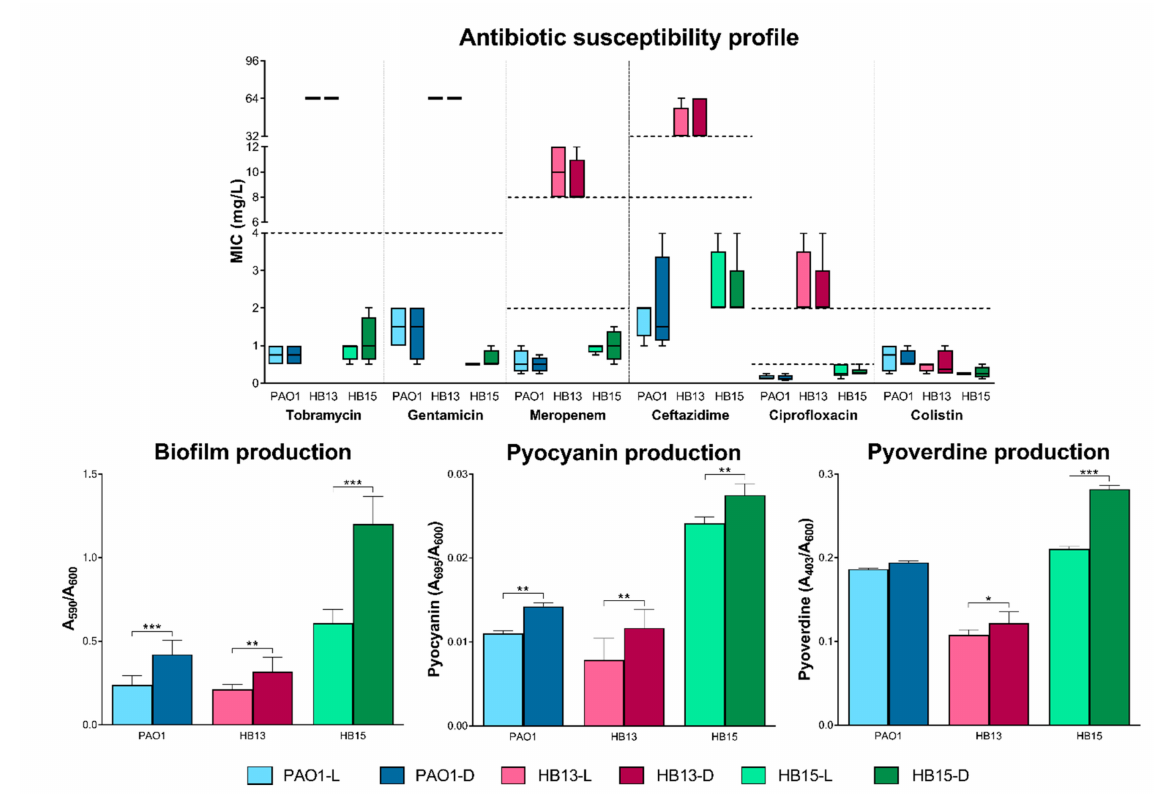
Figure 1. Phenotypic characterization of Pseudomonas aeruginosa grown in constant exposure to full-spectrum light (L) and total absence of light (D). Box and whiskers plots of the MICs of the six antibiotics screened, determined by broth microdi- lution. Horizontal dotted lines indicate the clinical susceptibility breakpoints [19]. Biofilm, pyocyanin and pyoverdine production quantified, respectively, by the absorbance measured at 590 nm [21], 695 nm [22], and at 403 nm [23], normalized by the cell density, monitored at 600 nm. Statistical comparisons performed by two-way ANOVA, followed by Tukey’s post hoc test for multiple comparisons. Significant differences comparing the two growth conditions are indicated as: * p < 0.05, ** p < 0.01, *** p < 0.001.